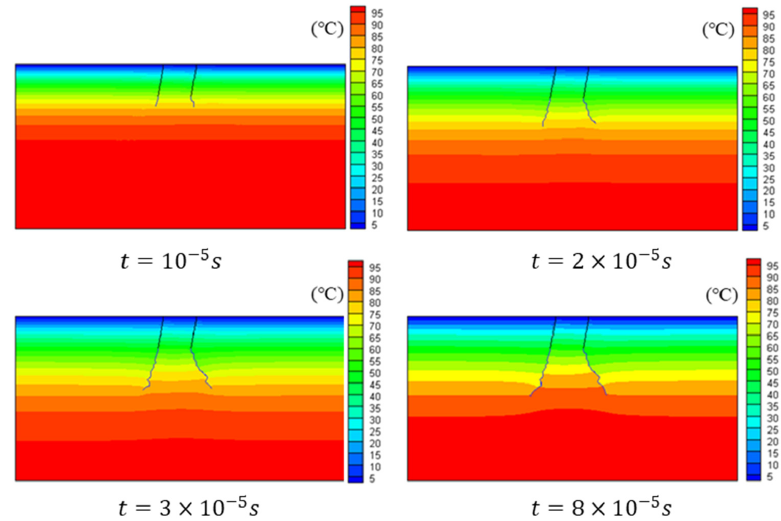
Figure 23. Evolution of temperature and crack with time under thermal load.